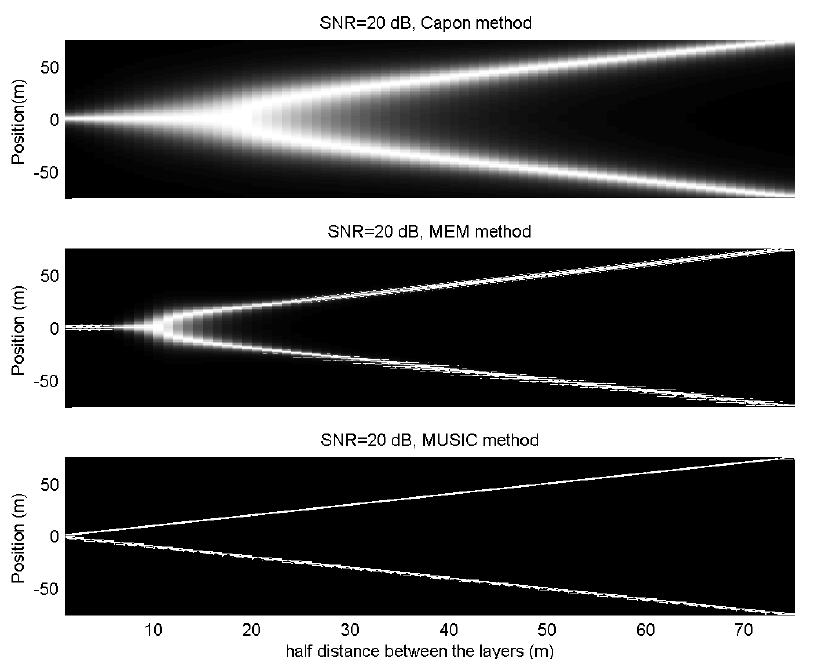
Fig. A1. Results of simulations for the Capon method (top), MEM (center) and MUSIC algorithm (bottom), assuming SNR = 20dB and two “infinitely” thin layers separated by 0m to 150m.